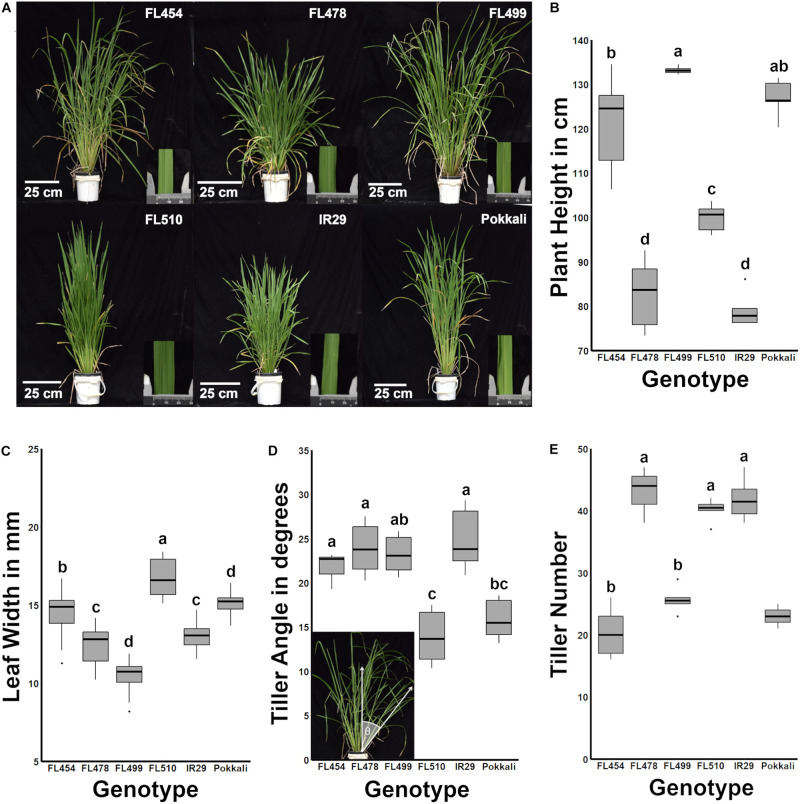
Morphological and growth habit profiles across the IR29 × Pokkali minimal comparative panel. The genotypic panel was grown under optimal conditions and compared morphologically and physiologically. (A) Gross-morphological differences highlighted the unique architecture of FL510. The inset photograph beside each plant shows a representative leaf under a caliper (units in mm). (B) Similarities across genotypes based on plant height (P < 0.05). FL454 and FL499, which are both sensitive to salt, are more similar to the tolerant donor parent Pokkali in terms of plant height, while FL478 is more similar to IR29. In contrast, FL510 is uniquely intermediate between the parents. (C) Box plots of leaf blade widths (n = 18) highlighting the uniqueness of FL510. In comparison, FL454 and FL478 are similar to the parents Pokkali and IR29, respectively. The super-sensitive FL499 has narrower leaves. (D) The tiller angle of each genotype (n = 6) was measured as the angle of the farthest tiller to its base as demonstrated in the inset photo and are shown as box plots. FL454, FL478, and FL499 are not significantly different from IR29 and have wider tiller angles compared to Pokkali and FL510 (P < 0.05). Tiller angle in FL499 was similar to Pokkali although it has a much higher mean value. (E) Number of tillers per plant showed that the genotypes with smaller statures (IR29, FL478, FL510) are more similar to each other with significantly higher values than the large-stature genotypes (Pokkali, FL454, FL499; P < 0.05). Taken together, morphological profiles indicate a compact architecture of FL510.